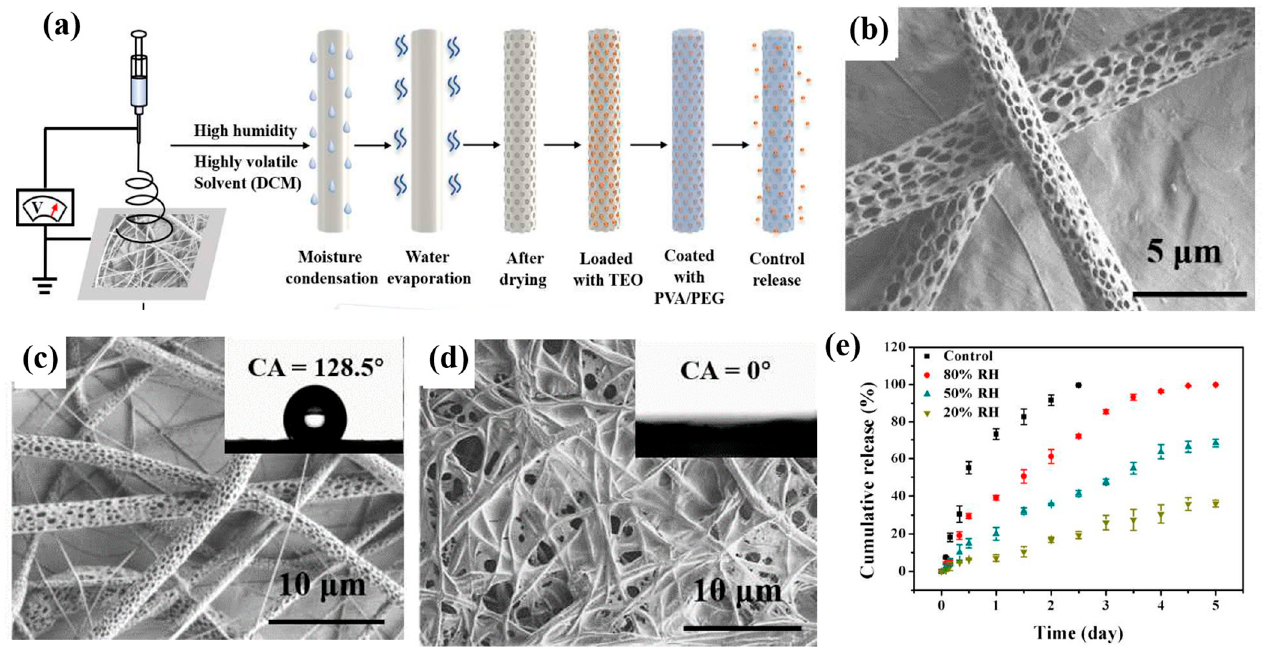
Figure 12. ( a ) Preparation process of PLA/TEO/PVA/PEG composite membrane under high-humidity conditions; ( b ) SEM photo of porous nanofiber membrane; ( c , d ) water contact angles of pure PLA and hydrophilic PLA/TEO/PVA/PEG nanofibers; ( e ) release behaviors of thyme essential oil (TEO) (at 20%, 50%, and 80% relative humidity). Reprinted with permission from Ref. [168], Copyright 2021, Elsevier.